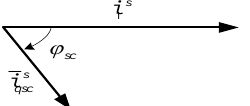
Figure 5. Current diagram in faulty case.